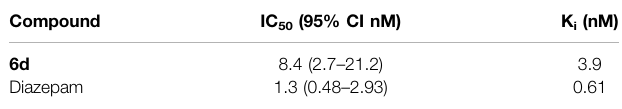
TABLE 6 | Binding af fi nity of compound 6d and diazepam competing on 3 H- fl umazenil to the benzodiazepine receptor.